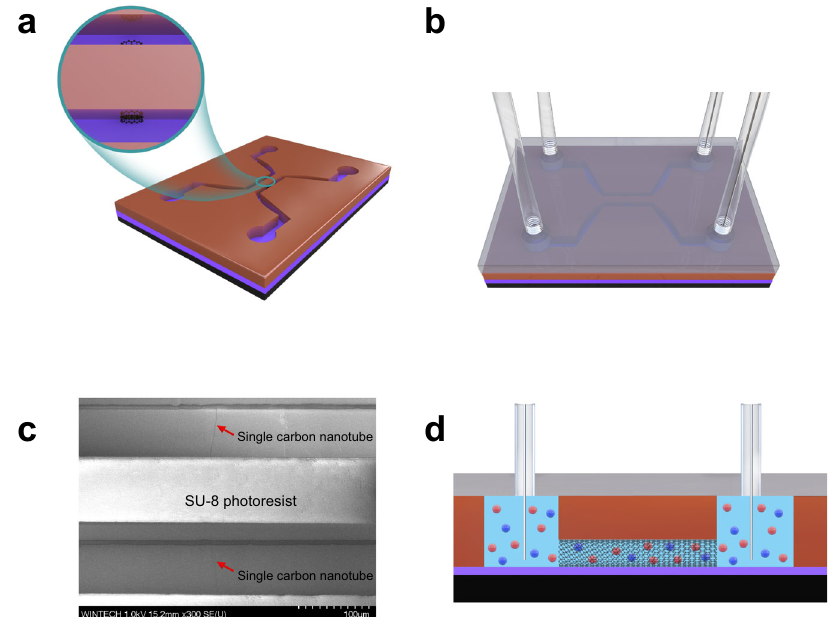
Fig. 1 | The single CNT nano fl uidic device and measurement setup. a The focus ion beam (FIB) precise etching technology removes the exposed parts of the CNT and opens both ends of CNT underneath the epoxy wall, which connects the two microchannels. In the schematic, silicon is black, silicon oxide is purple, SU-8 photoresist is brown. Carbon nanotube is a black rolled net. The enlarged inset shows the details of the opened CNT. b The PDMS is bonded on the SU-8 micro- channels after being immersed in an aqueous solution of ATPES. Then the liquid